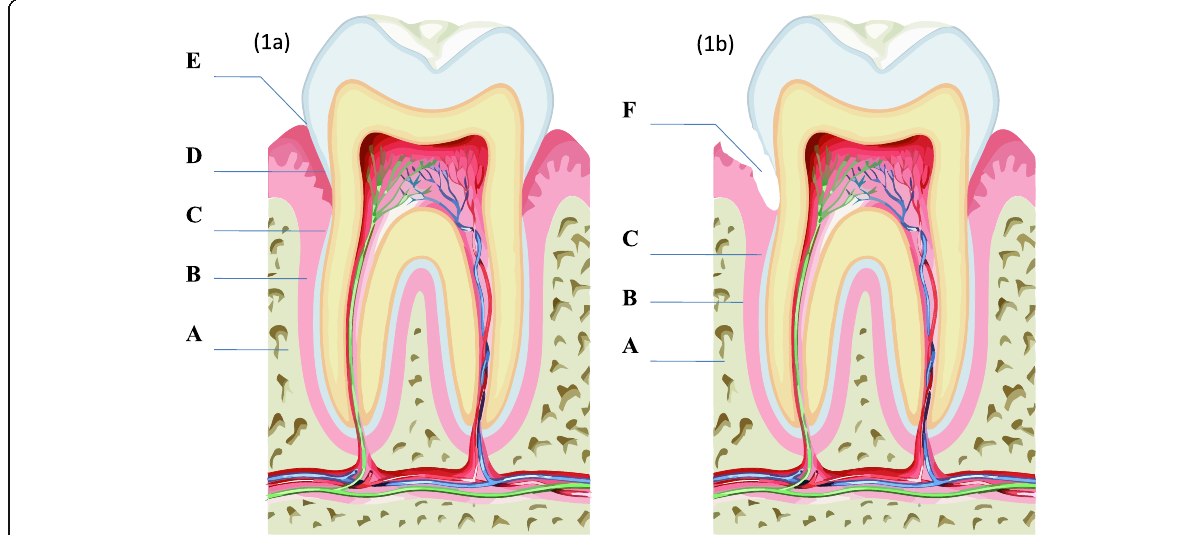
Fig. 1 Diagrammatic presentation of healthy versus pocket formed tooth. a Anatomy of healthy tooth. b Anatomy of the pocket formed tooth. A, alveolar bone; b , periodontal ligaments; c , cementum; d , cementum enamel junction; e , sulcus; and f , periodontal